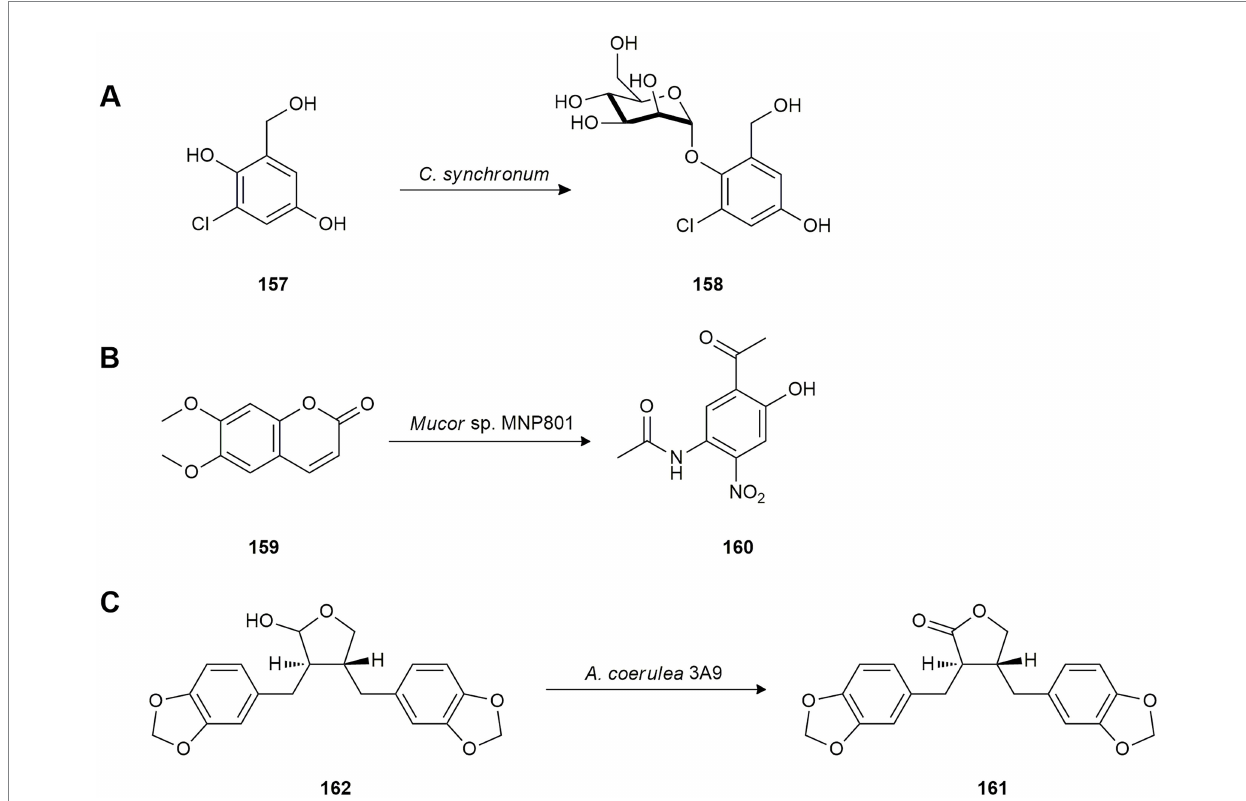
FIGURE 7 Biotransformations of other natural products. (A) Chlorogentisyl alcohol ( 157 ) mannosidation by Chrysosporium synchronium (Yun et al., 2011). (B) Scoparone ( 159 ) biotransformation by Mucor sp. MNP801 (Wang et al., 2010). (C) Hinokinin ( 161 ) production from cubetin ( 162 ) by Absidia coerulea 3A9 (de Souza et al.,